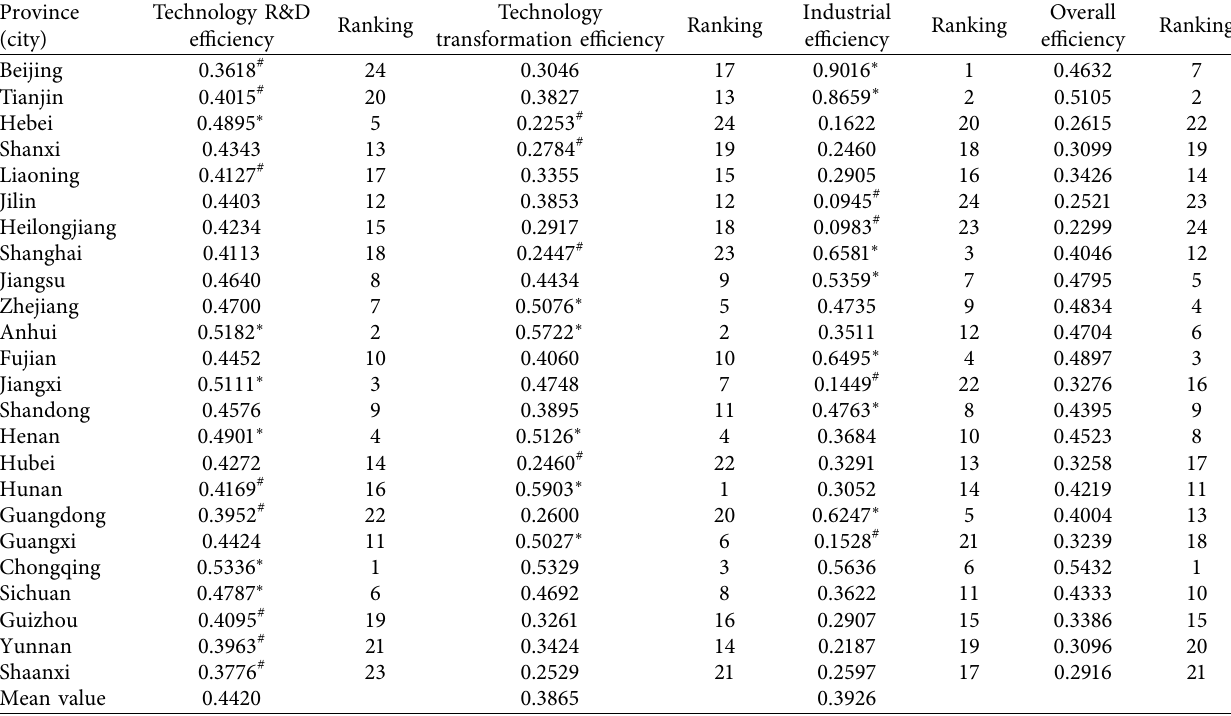
Table 5: Average value and ranking of three-stage technological innovation efficiency and total efficiency of Chinese provincial (municipal) high-tech industry from 2009 to